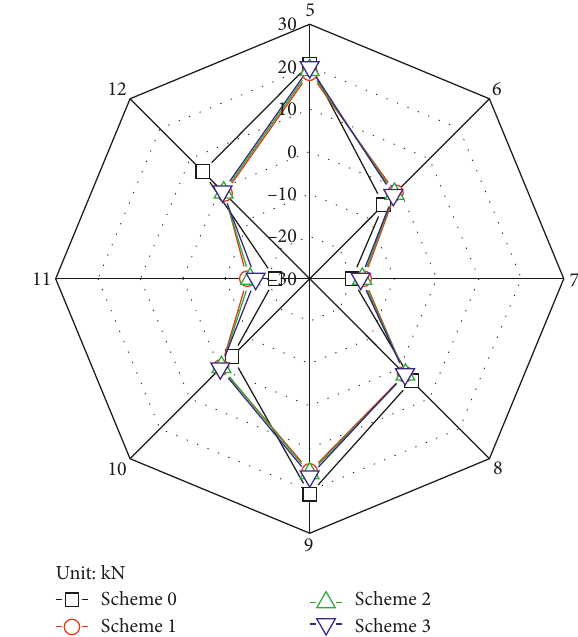
Figure 25: Additional shear forces of the tunnel structure after building